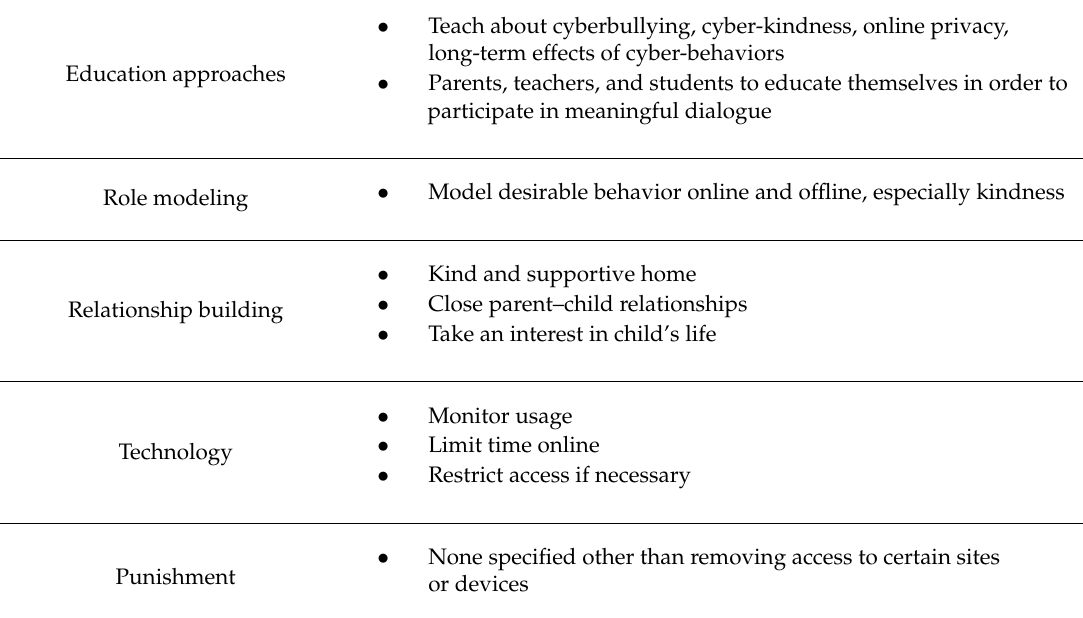
Table 2. Summary of key